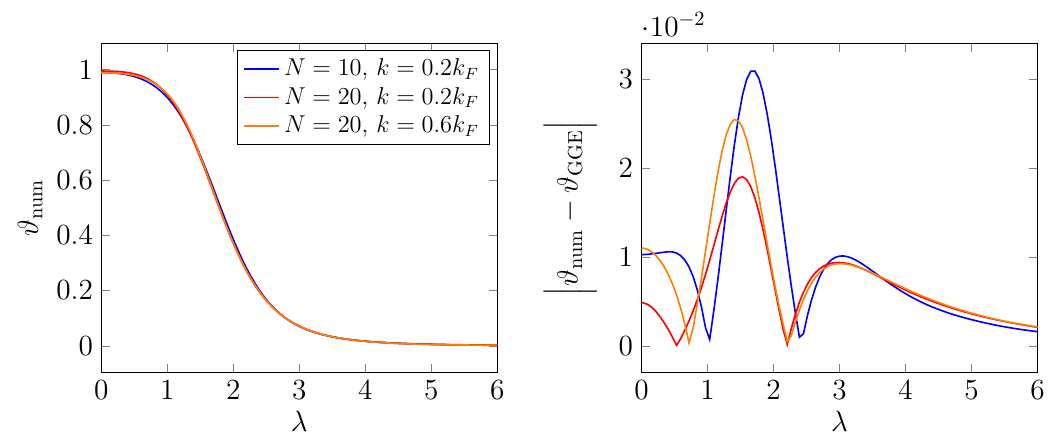
Figure 10: Left panel: Comparison between the distributions ϑ obtained from the Bragg num spectra measured at different system sizes N = 10 and N = 20 and different momenta k = 0.2 k and k = 0.6 k , in the quench c = 0 → c = 2. Right panel: plot of the differ- F F ence between the numerically computed ϑ (with the same system sizes N and momenta k num as in the left panel) and the exact distribution ϑ . We notice that larger system sizes N and GGE smaller momentum k give a more accurate prediction for ϑ ( λ ) around λ ∼ 0, while deviations in the tails remain relatively large due to the numerically truncated diagonal ensemble sum